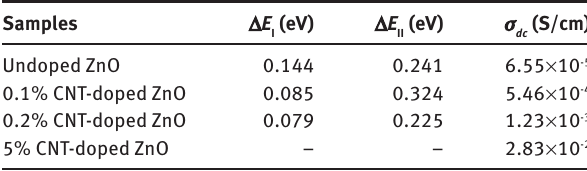
Table 1 The electronic parameters of the composites.